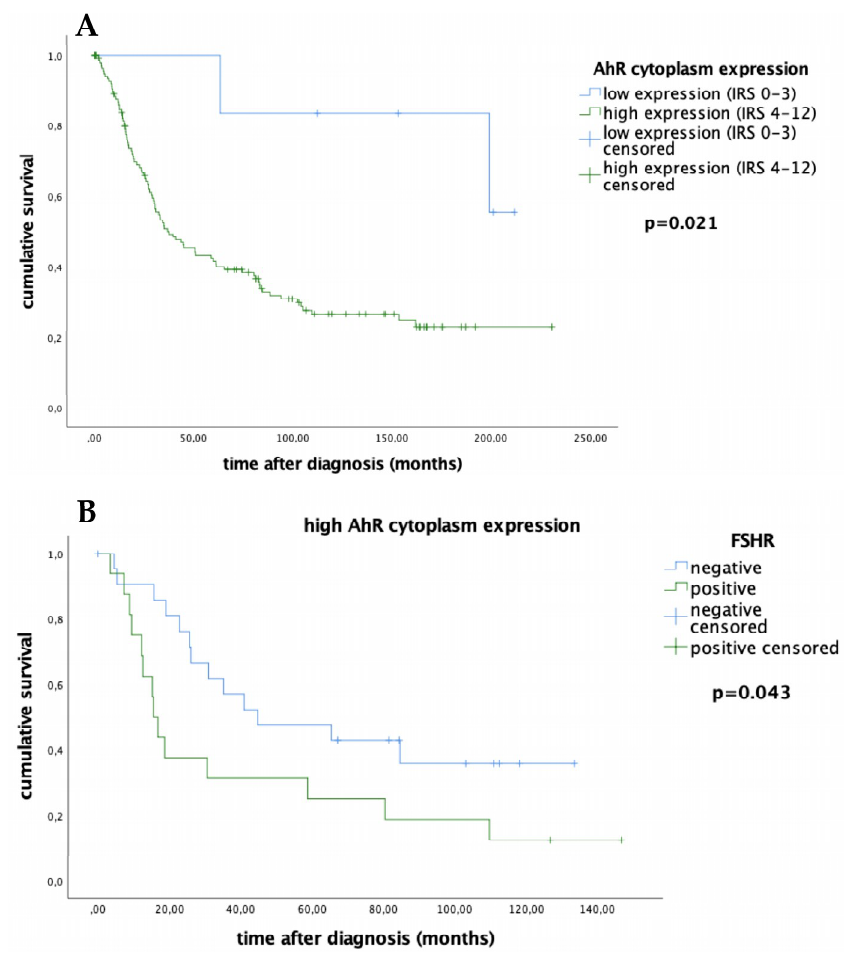
Figure 4. Correlation between AhR expression and overall survival. Ovarian cancer patients with low cytoplasmic AhR expression (IRS 0–3) tend to have better overall survival compared to those with high expression (IRS 4–12) ( p = 0.021) ( A ). For patients with higher cytoplasmic AhR expression, the amount of FSHR present changes their outcome ( B ).